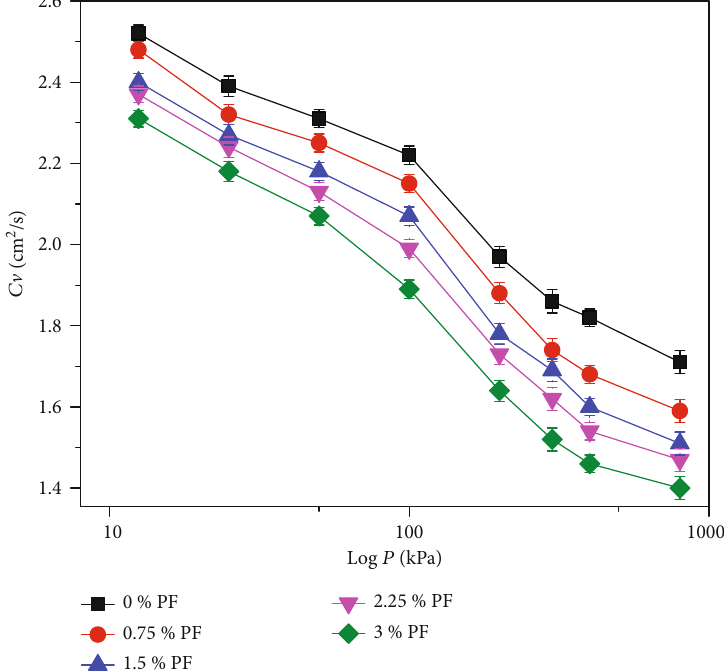
Figure 8: Coe ffi cient of consolidation ( Cv ) for unstabilised and PF-stabilised